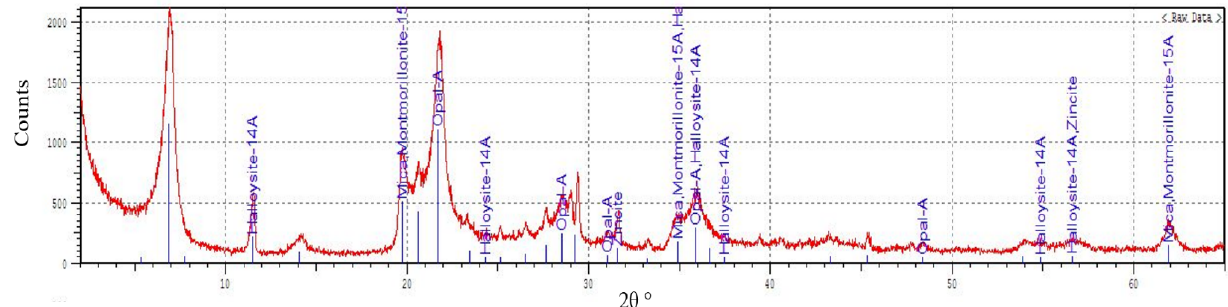
Figure 2. XRD of bentonite clay used in this study. Table 2. XRF elemental analysis of used bentonite.